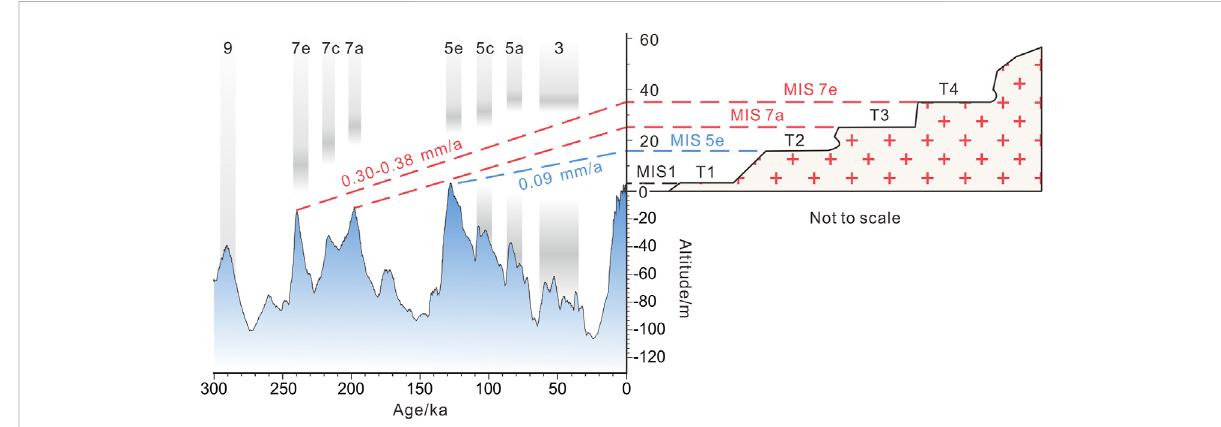
FIGURE 7 Calculatedupliftratesfromallocationsbetweenthealtitudesofwave-cutplatformsandtheagesofsea-levelhighstands.Thesea-leveldataare from Grant et al. (2014). Light gray bands: marine isotope stages